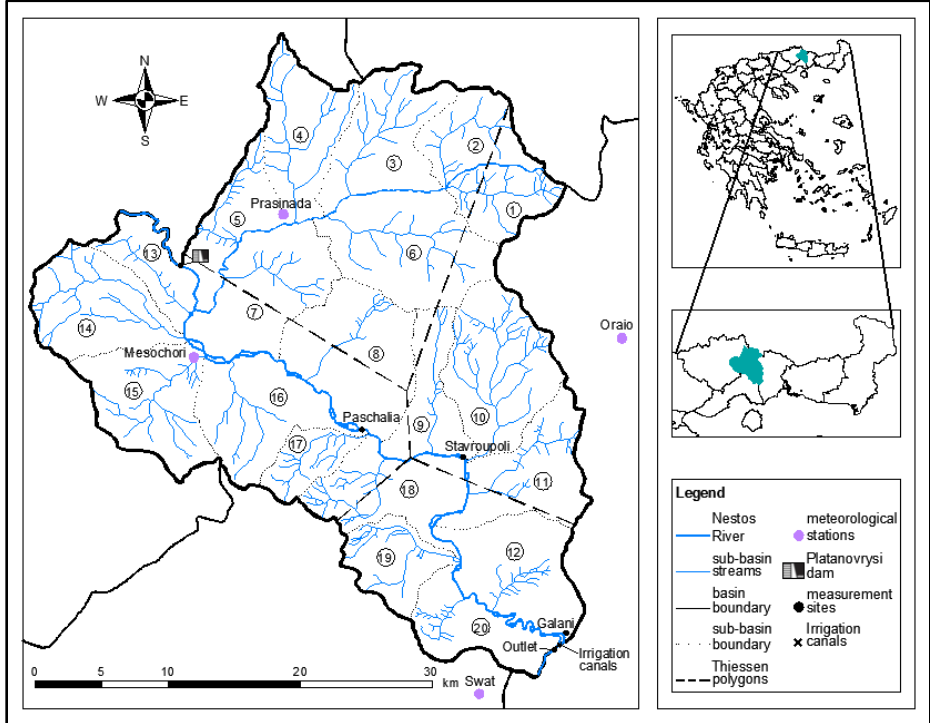
Figure 1. Nestos River